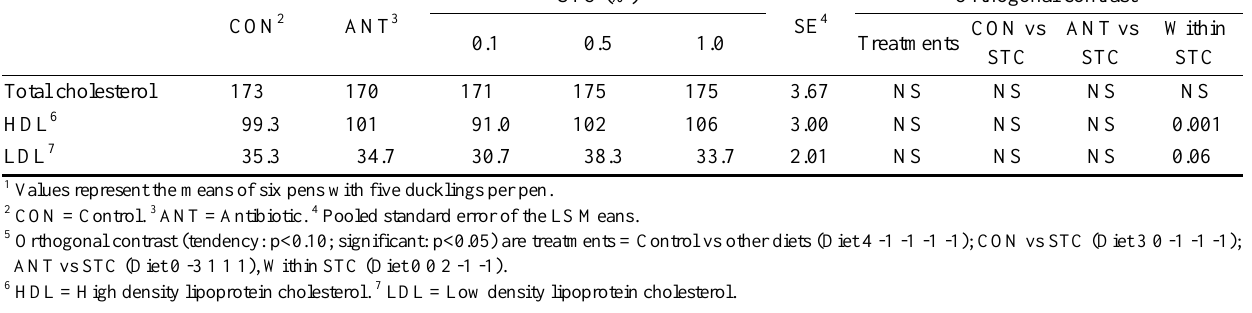
Table 6. Least squares means for the effect of dietary sea tangle ( L. japonica ) and charcoal supplementation on meat thiobarbituric acid reactive substances (TBARS) value of duck breast muscle 1 CON 2 Within Fresh 1 Values represent the means of six pens with five ducklings per pen. 2 CON = Control. 3 ANT = Antibiotic. 4 Pooled standard error of the LS Means. 5 Orthogonal contrast (tendency: p<0.10; significant: p<0.05) are treatments = Control vs other diets (Diet 4 -1 -1 -1 -1); CON vs STC (Diet 3 0 -1 -1 -1); ANT vs STC (Diet 0 -3 1 1 1), Within STC (Diet 0 0 2 -1 -1).